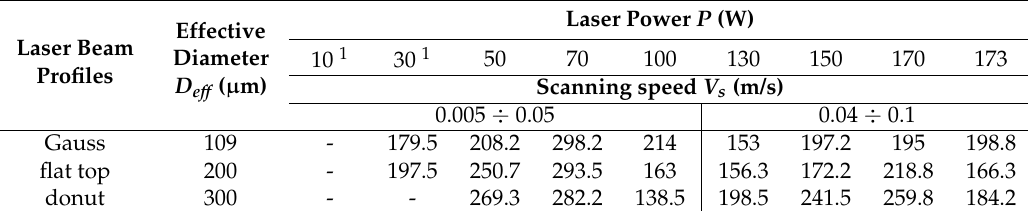
Table 6. The average values of relative HAZ C z.r ( µ m) during SLM production of single tracks from CoCrMo powder with the height of the layer ~80 µ